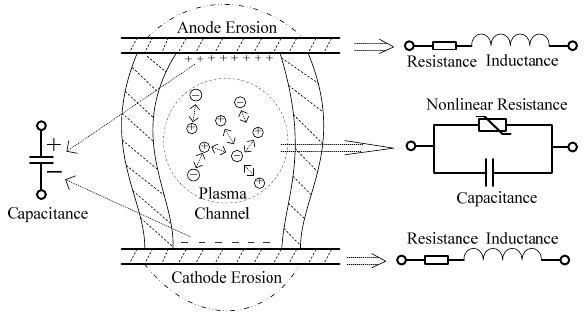
Figure 1. Autonomous EDM mechanism model.